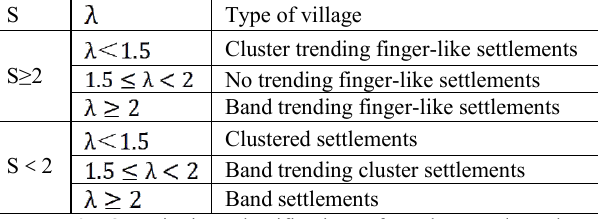
Table 2 . Quantitative classification of settlement boundary patterns.